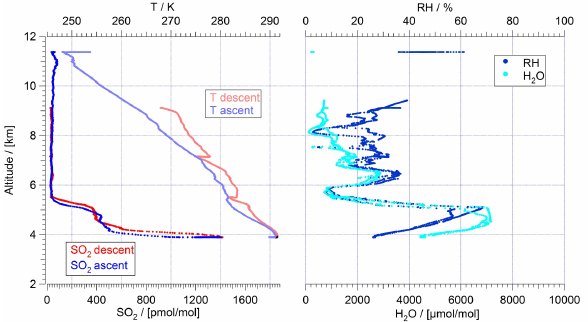
Fig. 4. Altitude profiles of the measured SO 2 mole fraction and the Temperature (first panel, measurements during the descent of the Falcon in red, during reascent in blue). Altitude profile of the measured water vapor concentration and relative humidity (second panel).